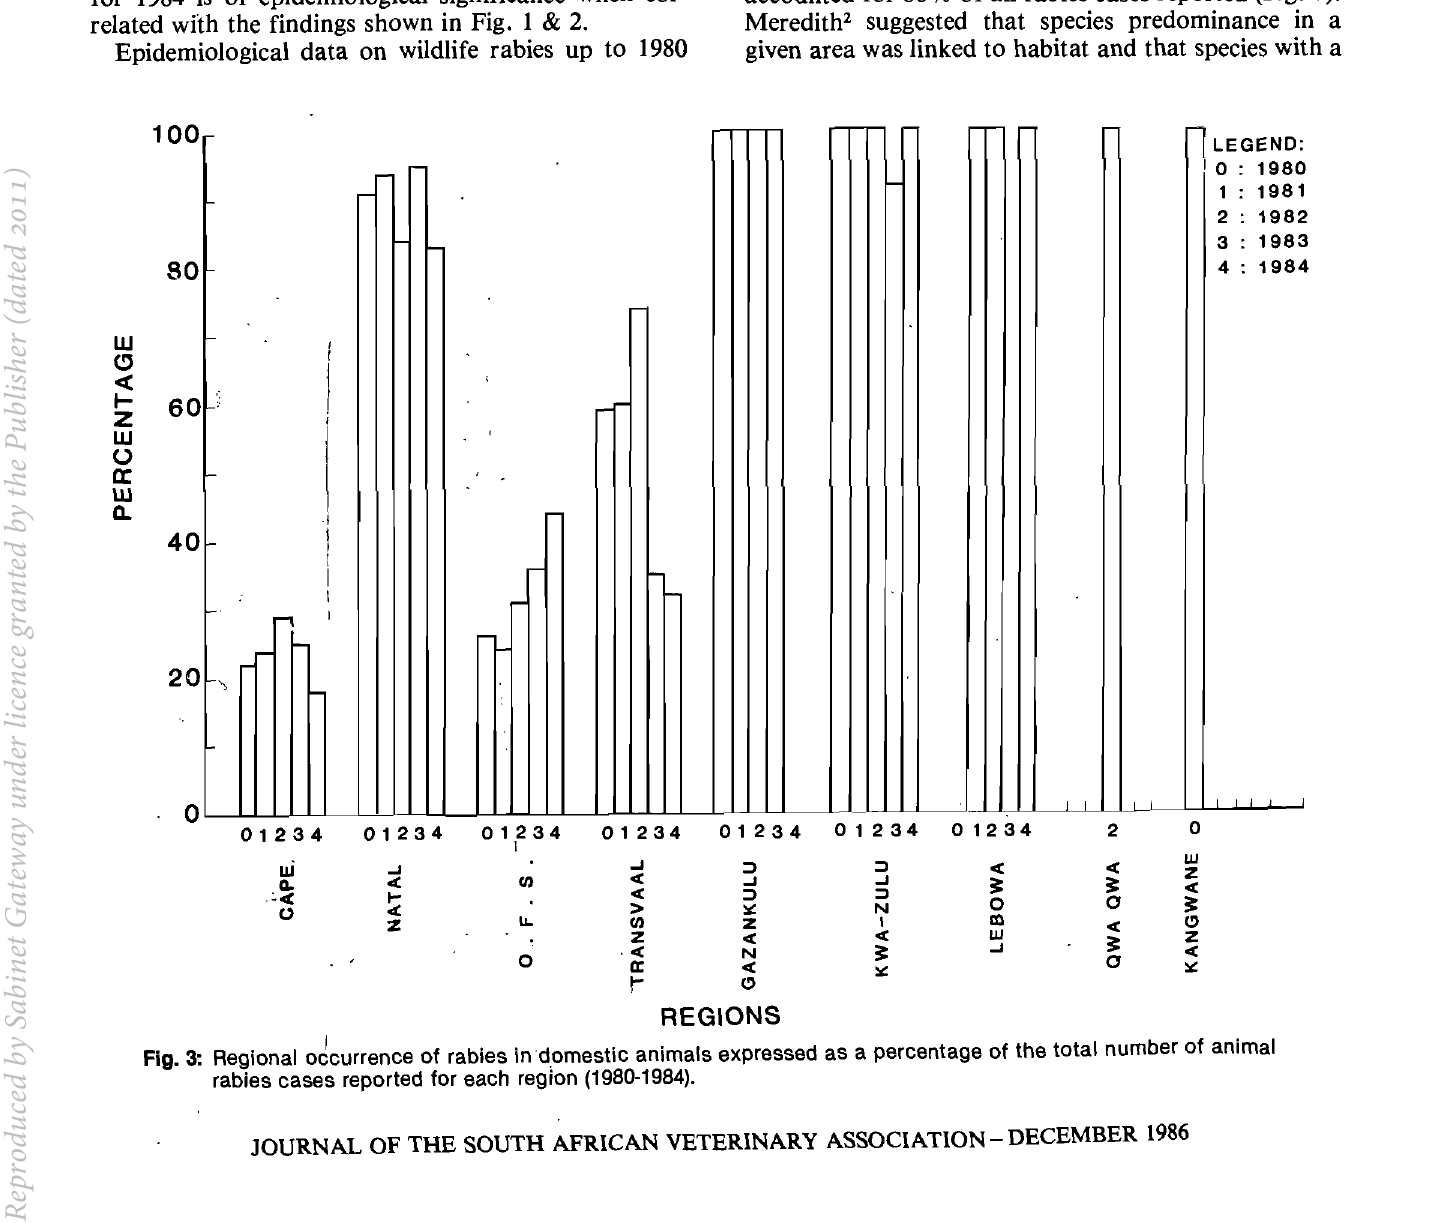
Fig. 3: Regional o6currence of rabies in domestic animals expressed as a percentage of the total number of animal rabies cases reported for each region